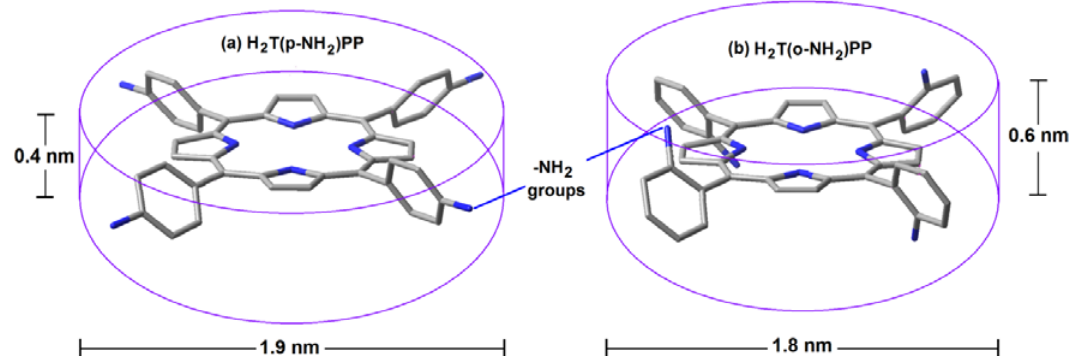
Figure 12. Schematic structures showing the approximate dimensions of isomeric tetraphenylporphyrine substituted with amino groups in: ( a ) para or ( b ) ortho positions. For simplicity, H atoms and double bonds are